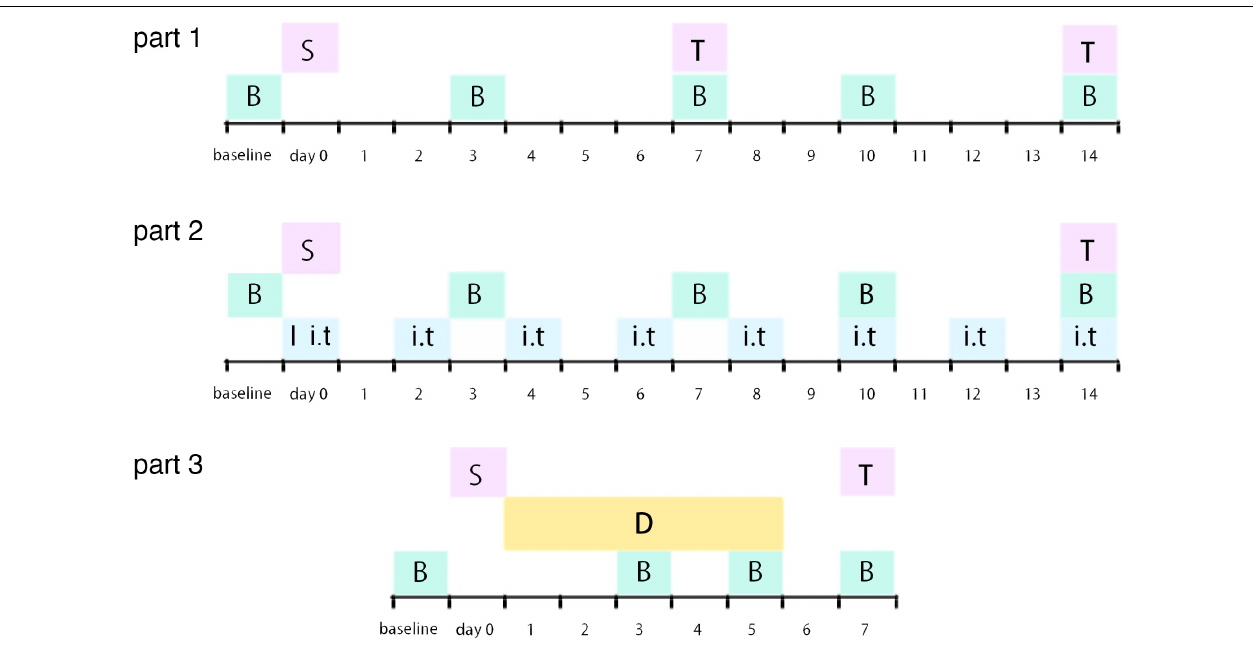
FIGURE 1 | Illustration of experimental timeline S: surgery procedure; T: tissue collection; B: behavioral tests; I: catheter implantation; i.t.: intrathecal injection (RAP/3-MA/TM/4-PBA or vehicle); D: dexmedetomidine (or vehicle)